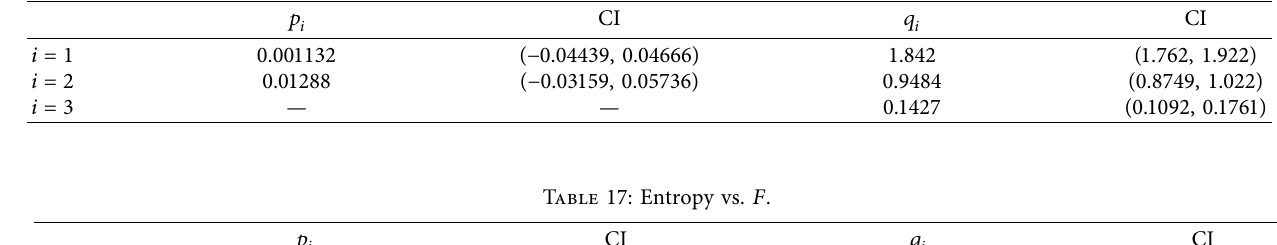
Table 16: Entropy vs. HM.